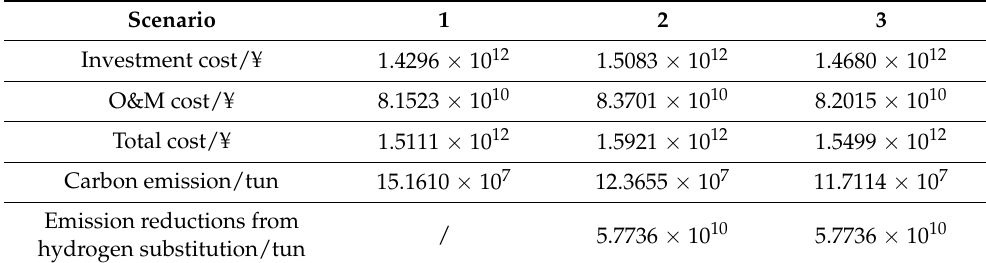
Table 5. The cost and carbon emission reduction of three scenarios.